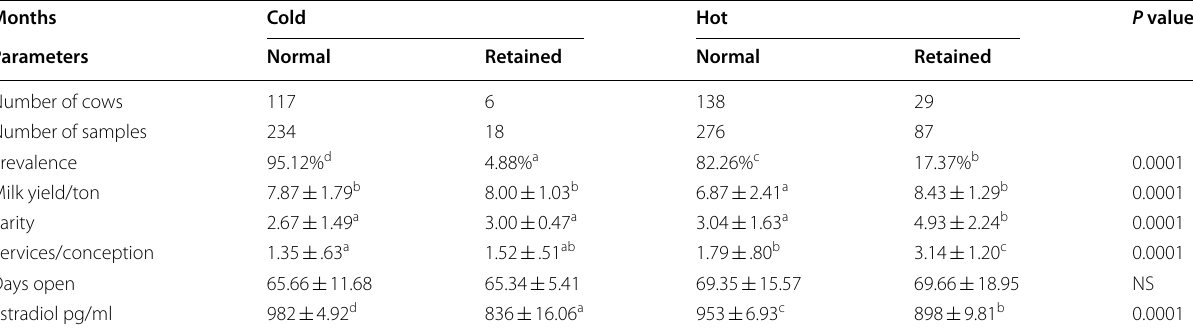
Means with different superscripts (a, b, c, d) are significant at P < 0.05, NS (non‑significant)